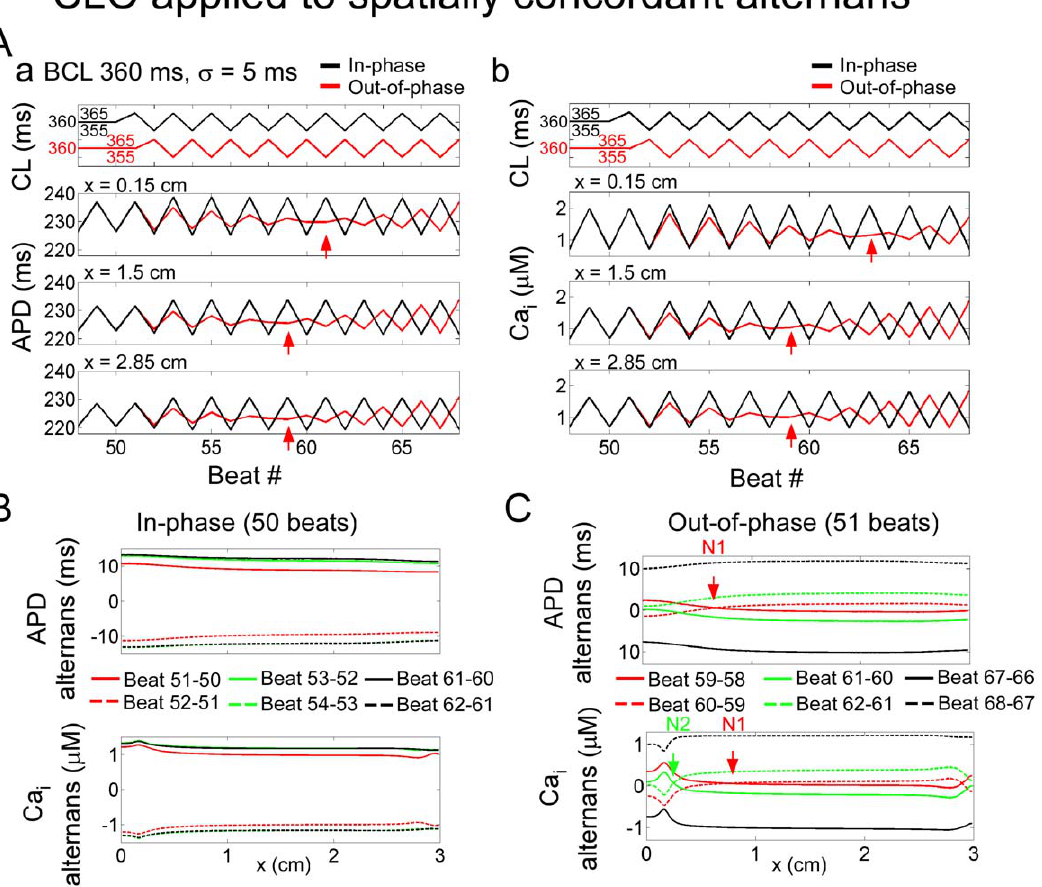
Figure 2. Cycle length oscillation applied during spatially concordant alternans in a one-dimensional cable ionic model. Simulation results are for the condition in which constant pacing at 360 ms induced spatially concordant alternans ( u =10 s 2 1 ). A. CLO applied when alternans induced near the pacing site was in-phase (black traces) and out-of-phase (red traces). (a) APD and (b) Ca i transient amplitude measurements as a function of beat number at locations near the pacing site (x=0.15 cm, top panels), center of the cable (x=1.5 cm, middle), and end of the cable (x=2.85 cm, bottom). CL is shown for reference above each set of plots. Phase reversal is indicated by a red arrow. B, C. APD (top) and Ca i (bottom) alternans amplitudes along the length of the cable for sequential beat pairs, for CLO initially in-phase (after 50 beats) ( B ) or out-of-phase (after 51 beats) ( C ) with the alternans at the pacing site. Traces for successive beat pairs have the same shading. Nodes (N) are indicated and numbered in order of